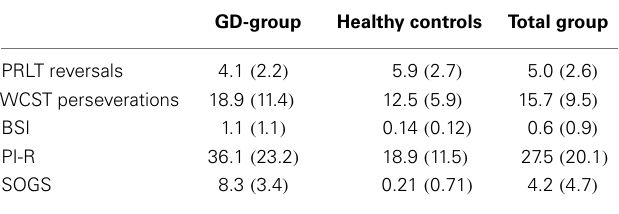
group on PRLT reversals,WCST perseverations, BSI, PI-R, and SOGS